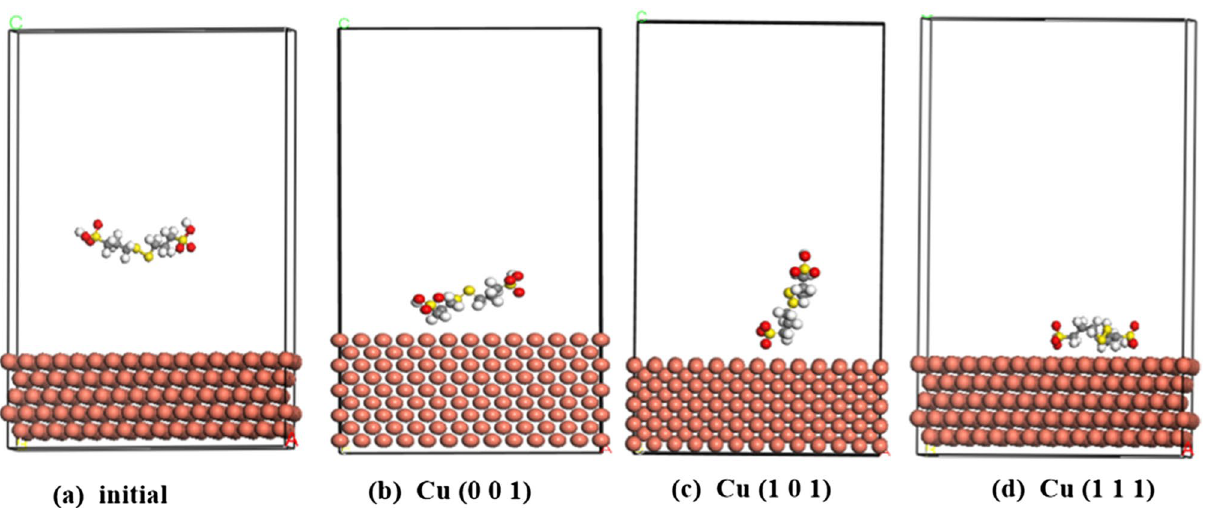
Figure 4. Configuration of SPS adsorbed on Cu (001), Cu (101) and Cu (111) surface. ( a ) Side view of initial stage on Cu (111), ( b ) side view of equilibrium stage on Cu (001) surface ( c ) side view of equilibrium stage on Cu (101) surface. ( d ) side view of equilibrium stage on Cu (101) surface ( https:// www. 3ds. com/ produ cts- servi ces/ biovia/ material studio